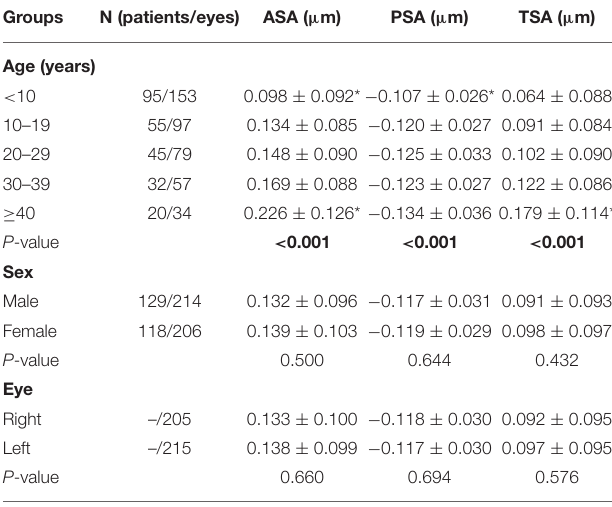
TABLE 3 | Anterior, posterior, and total spherical aberration of the cornea with a 6-mm pupil size in patients with bilateral ectopia lentis divided by age, sex, and